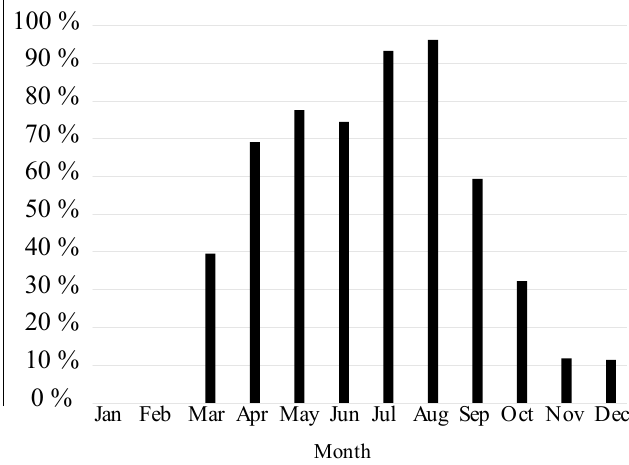
Figure 7. Measured monthly solar fraction of the retrofitted solar domestic hot water system. Table 4. Measured annual values of the solar fraction and auxiliary energy need, and the corresponding calculated annual energy savings and energy need.